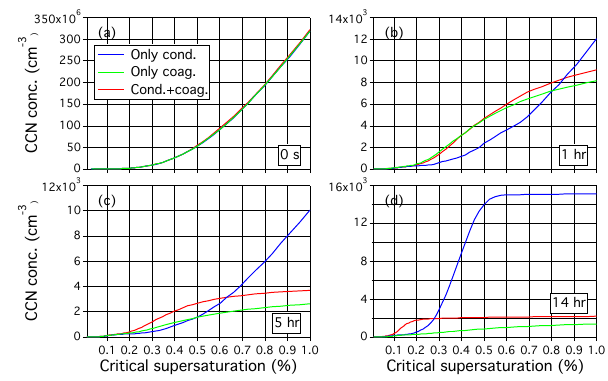
Figure 10. CCN number concentrations as the function of critical supersaturation at 0s, 1h, 5h and 14h for the sensitivity